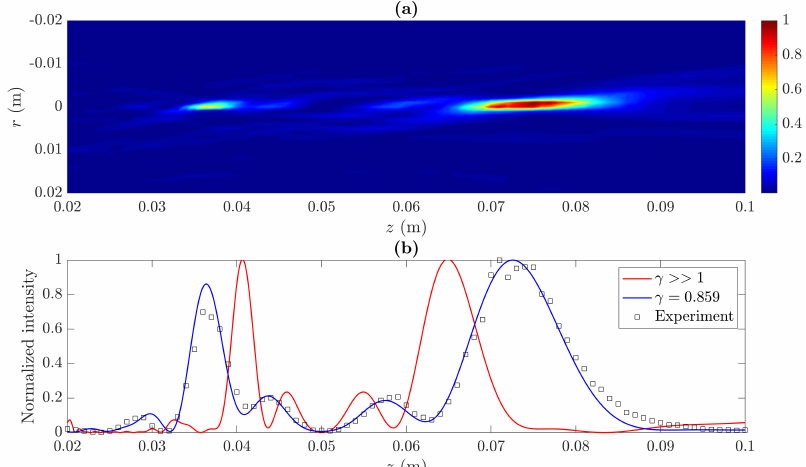
Figure 8. Experimental results: ( a ) measured intensity map, ( b ) measured (black squares) and simulated (blue line) focusing profiles for the MbZP built lens compared to the γ >> 1 case (red